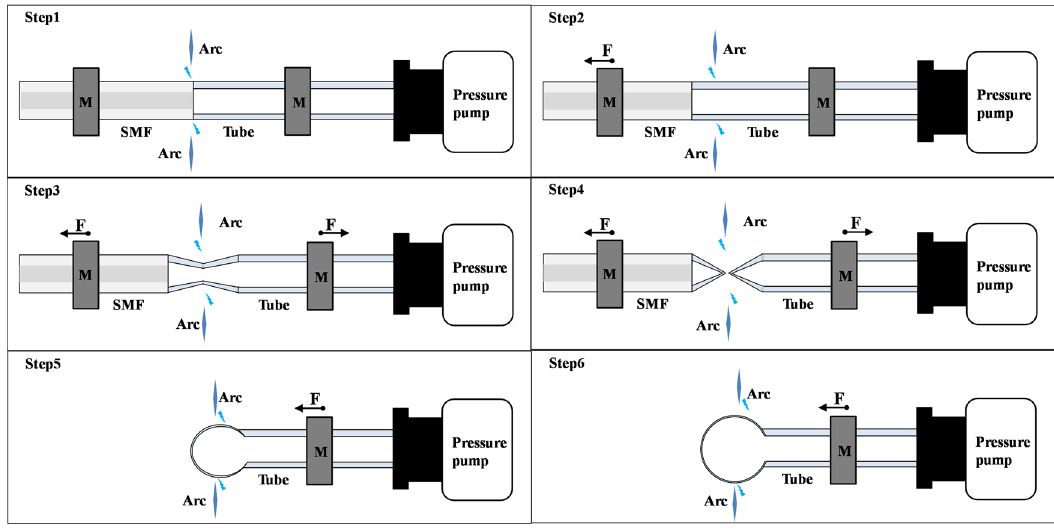
Figure 1. Fabrication process of microbubble.